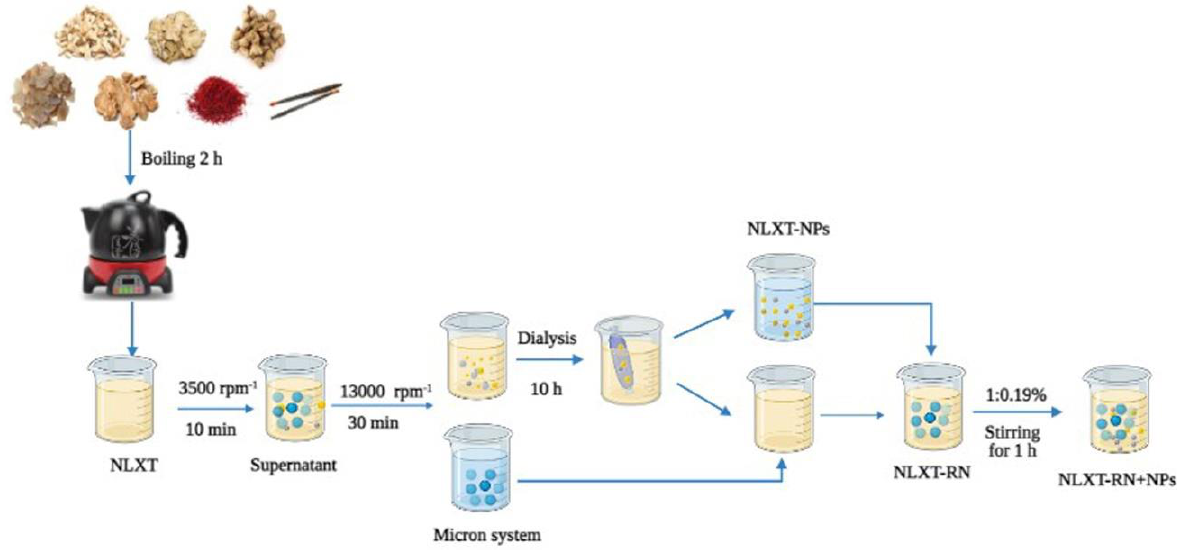
Figure 7. NLXT − NPs isolation process diagram.